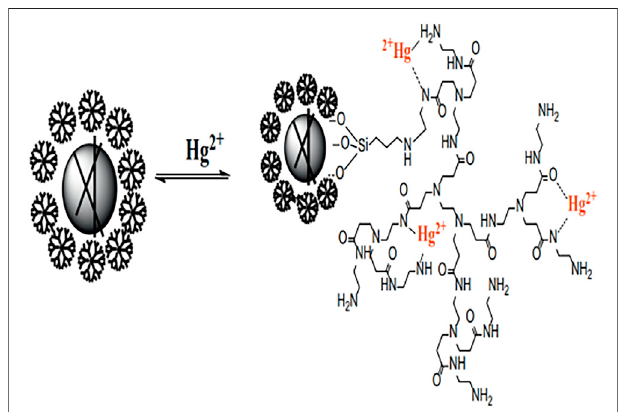
FIGURE 6 | Proposed binding mechanism of PAMAM-ATP with